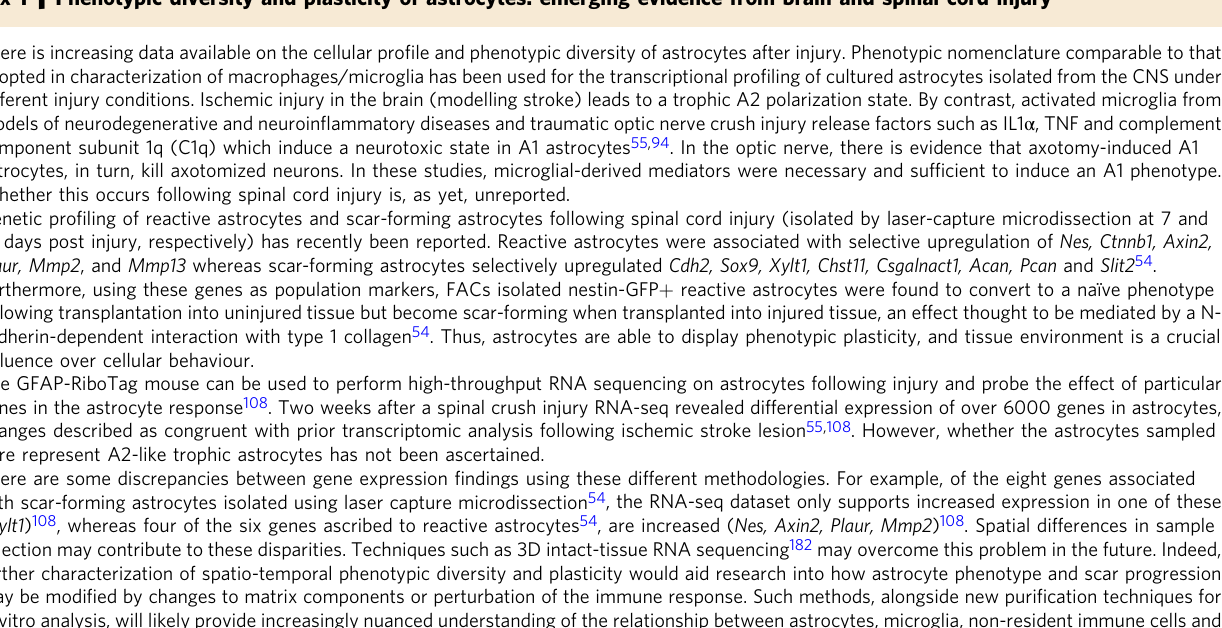
zipper-bearing kinase (LZK, MAP3K13) expression 56 . Ependymal cell-derived astrocyte-like progeny contribute to this population